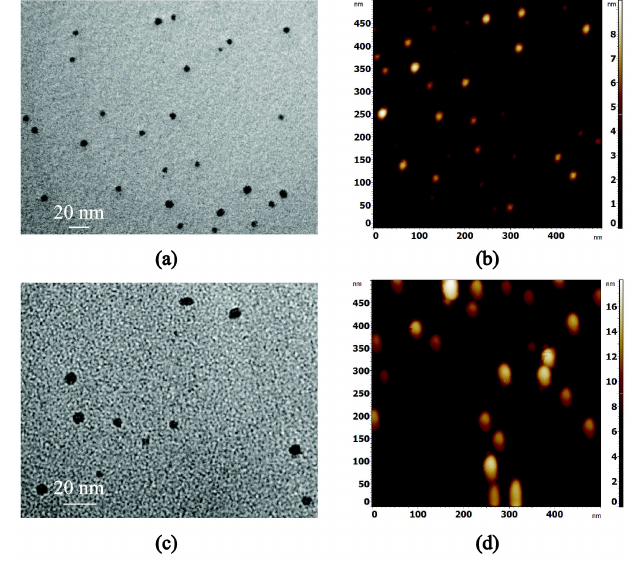
Figure 3. TEM ( a , c ) and AFM ( b , d ) images of Ag ( a , b ) and Ti ( c , d ) NPs synthesized using the nanoparticle source. Nominal diameters for Ag and Ti were 4 nm and 10 nm.